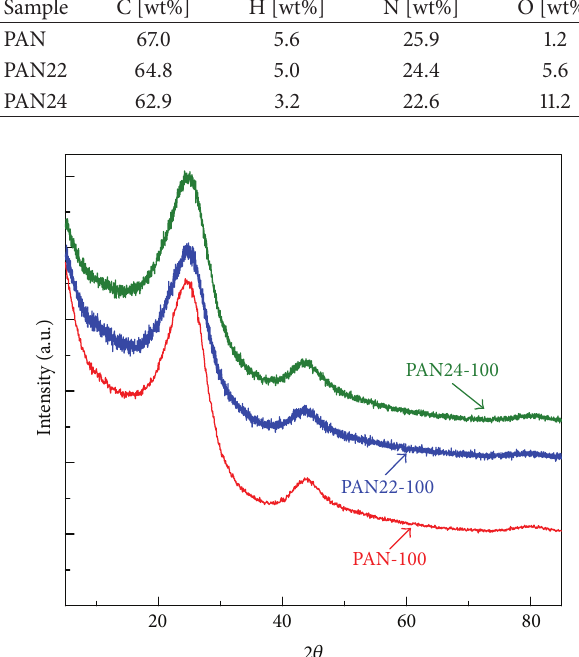
Figure 2: X-ray diffraction patterns of 1000 ∘ C carbons from pristine and oxidized